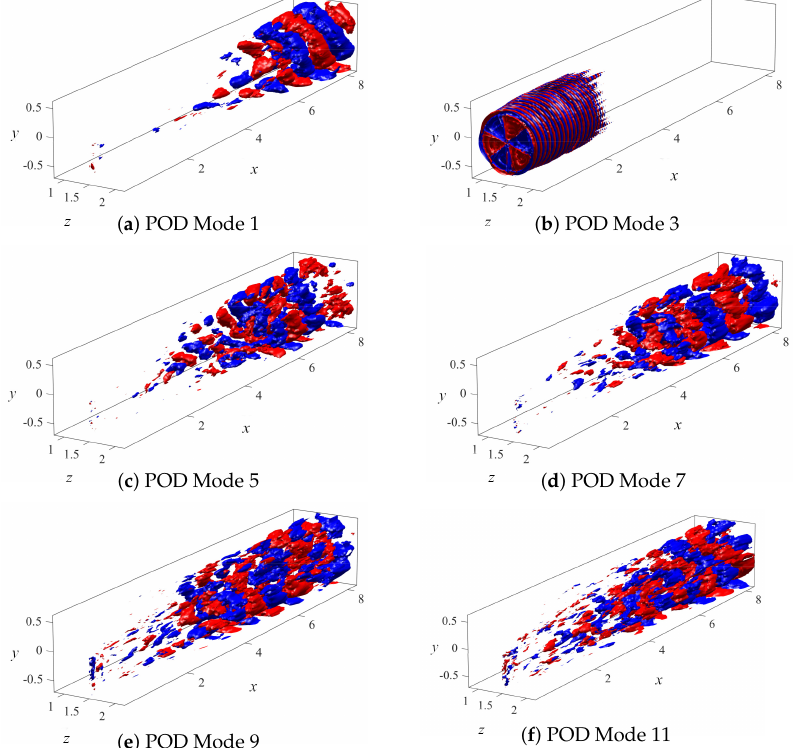
Figure 4. Streamwise velocity iso-surfaces of the most energetic POD modes (red for u = 0.001, blue for u = − 0.001).